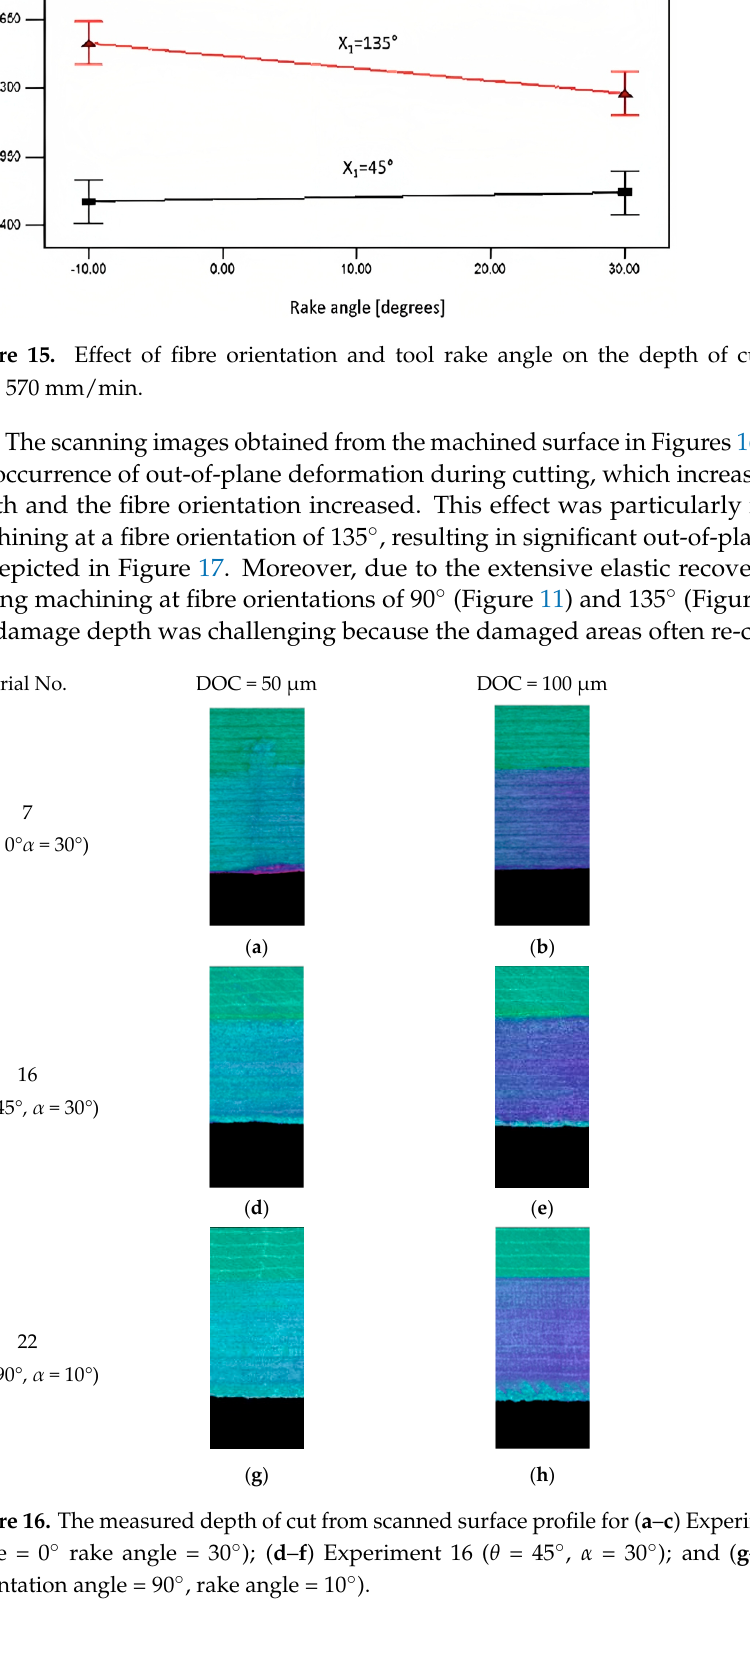
Figure 16. The measured depth of cut from scanned surface profile for ( a – c ) Experiment 7 (orientation angle = 0° rake angle = 30°); ( d – f ) Experiment 16 ( θ = 45°, α = 30°); and ( g – i ) Experiment 22 (orientation angle = 90°, rake angle = 10°).